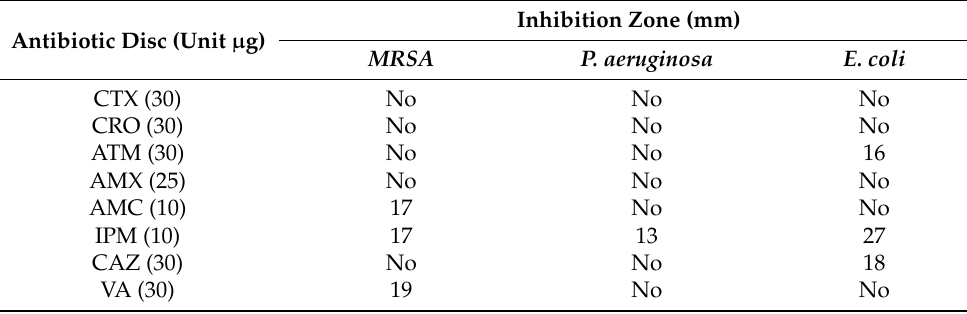
Figure 6. Per cent hemolysis study to confirm no harmful effect of our formulation on RBCs. Table 2. Determining the resistance pattern of different antibiotic